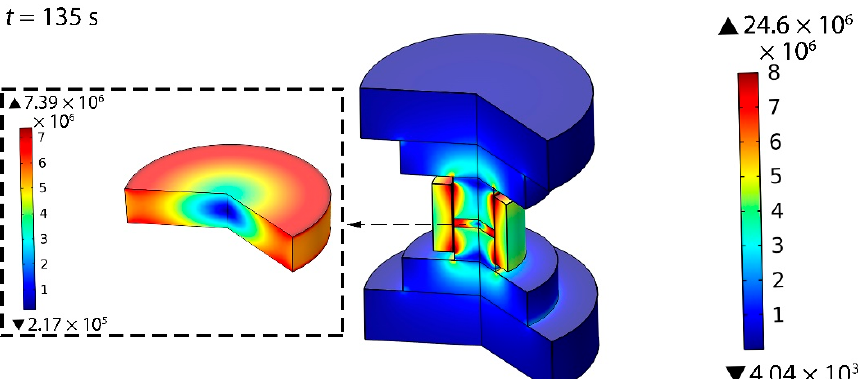
Figure 9. Conductive heat flux (W/m 2 ) in the sample and other sintering tooling in the final second of the test ( t = 135